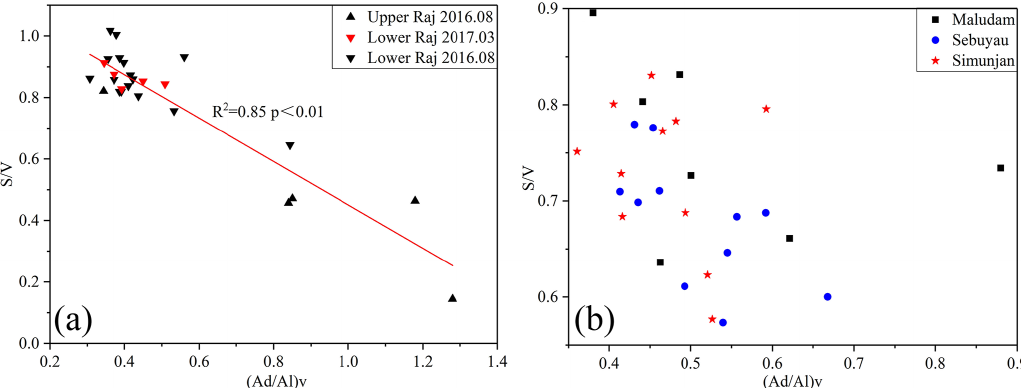
Figure 5. Relationship between ( Ad / Al ) V and S / V ratios based on average values of the various systems for (a) the Rajang and (b) the small river